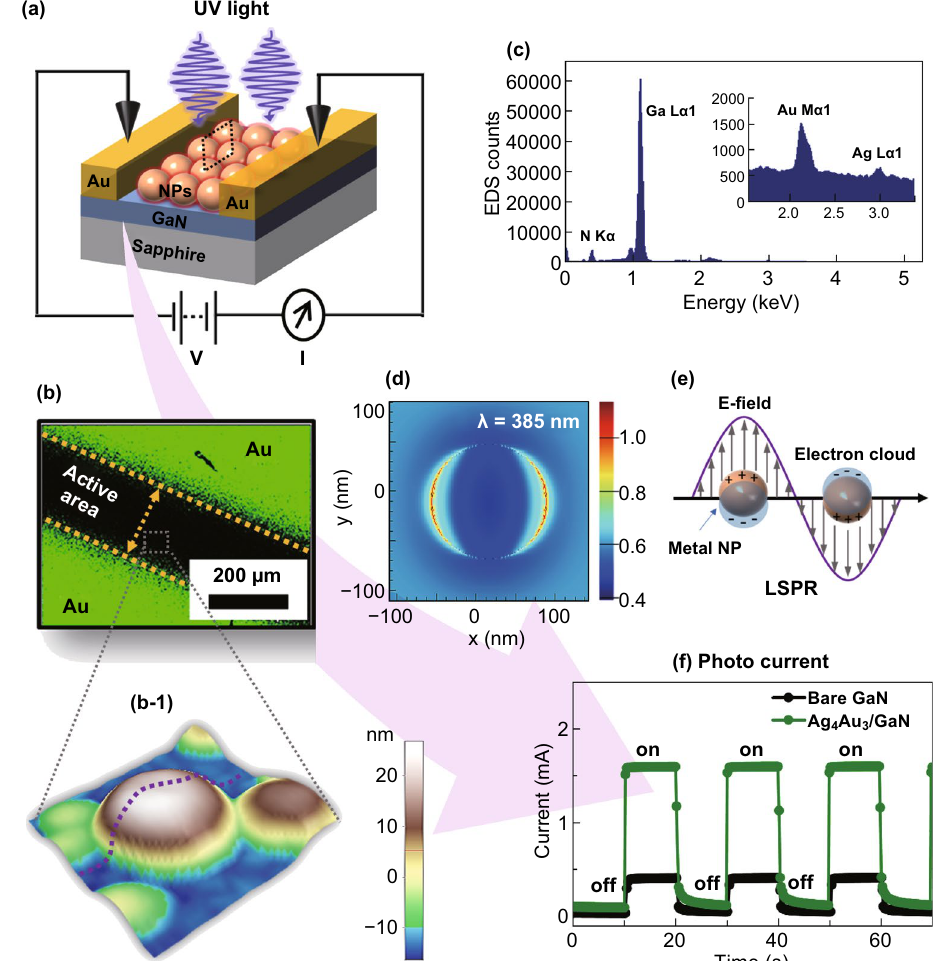
Fig. 1 a Schematic of plasmonic metallic NPs based UV photodetector on GaN. b EDS elemental map of the photodetector active region and Au electrode. ( b-1 ) AFM surface morphology of typical metallic NPs in the active region. c EDS spectra of NPs in the active region. d E‑field distribution of typical metallic NP by finite‑difference time domain (FDTD) simulation. e Schematic of localized surface plasmon resonance (LSPR) induced on the metal NPs by incident light. f Photoresponse of the bare GaN and Ag 4 Au 3 at 0.1 V bias upon illumination of UV (385 nm)